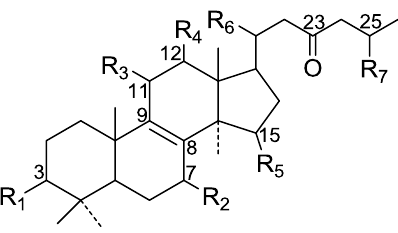
Figure 2. Structures of compounds 1 – 37